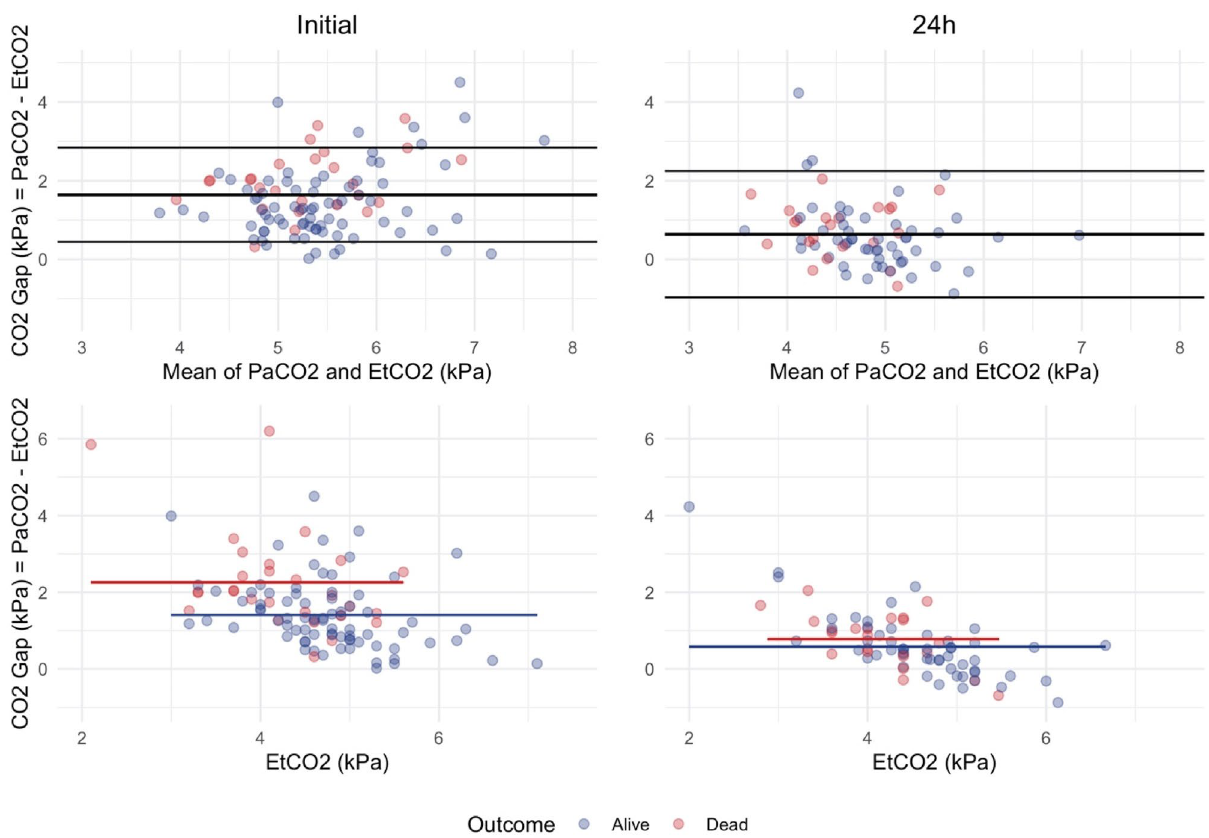
Figure 2. Bland–Altman plots and point plots comparing PaCO2 and EtCO2. Top row: Bland–Altman plots for all available pairs of PaCO2 and EtCO2 at different time points. Bottom row: corresponding point plots for the same data. The red and blue lines illustrate the mean CO2 gap for deceased and surviving patients, respectively. The mean CO2 gap lines are trimmed, illustrating the EtCO2 range for both groups, respectively. Difference between PaCO2 and EtCO2 was highly significant for the initial pairs (p < 0.001) but not for the pairs after 24 h (see Table 2). Figures were created using RStudio (2020). RStudio: Integrated Development for R. RStudio, PBC, Boston, MA URL http:// www. rstud io. com/ and the package ggplot2 by Wickham H